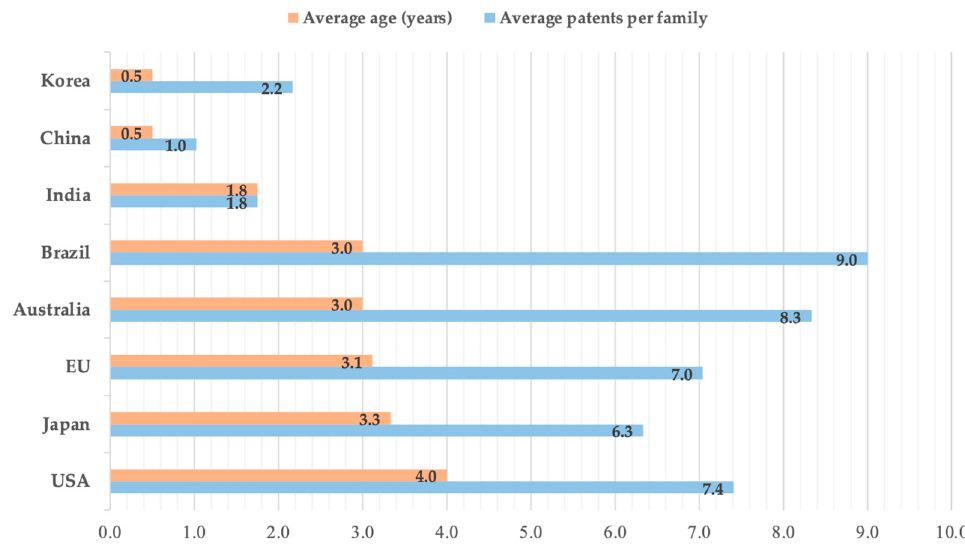
Figure 3. Average age of patent families and average number of patents per family.